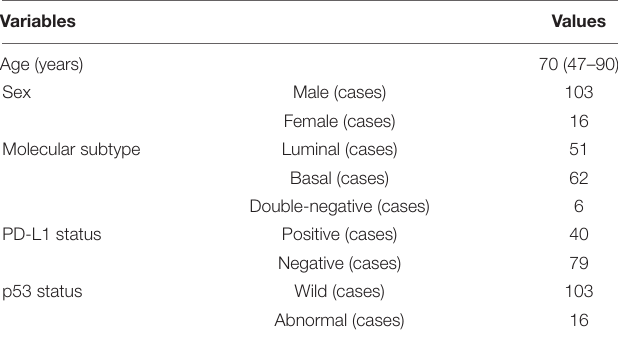
TABLE 1 | Clinical features and molecular information of patients with muscle-invasive bladder cancer